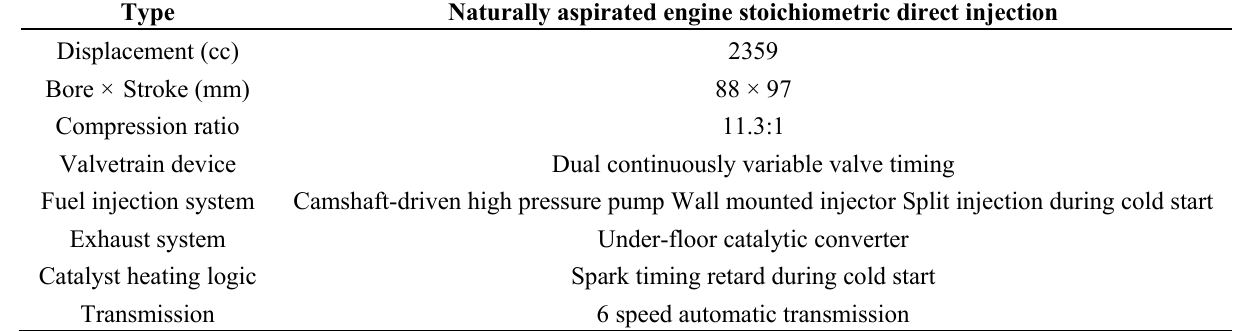
Table 1. Specifications of test engine and